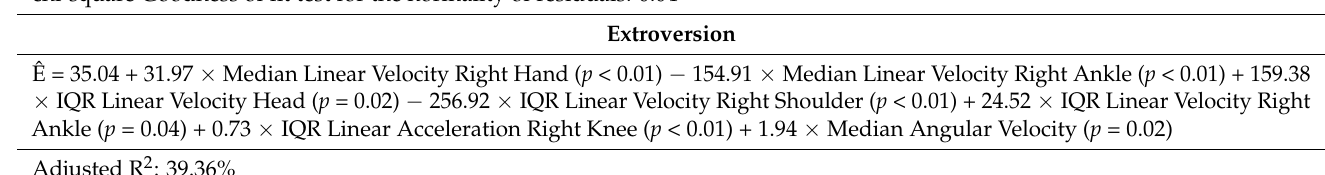
Table 1. Coefficients (and p -values of the coefficients) obtained using stepwise linear regression for each of the five personality traits. For each trait, the R 2 /Adjusted R 2 and p -value of the chi-square normality test for residuals are shown. Neuroticism